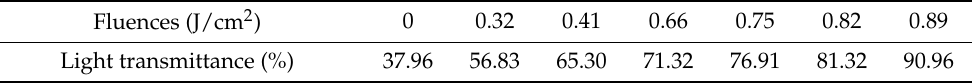
Figure 15. Light transmittance spectra of ITO films with LSFLs fabricated by femtosecond laser direct writing with different pulse fluences. The scanning velocity was fixed at 3.0 mm/s. Table 1. The average transmittance in the near-infrared band from 1200 to 1900 nm for LSFL fabricated by femtosecond laser direct writing with different pulse fluences (0~0.89 J/cm 2 ).